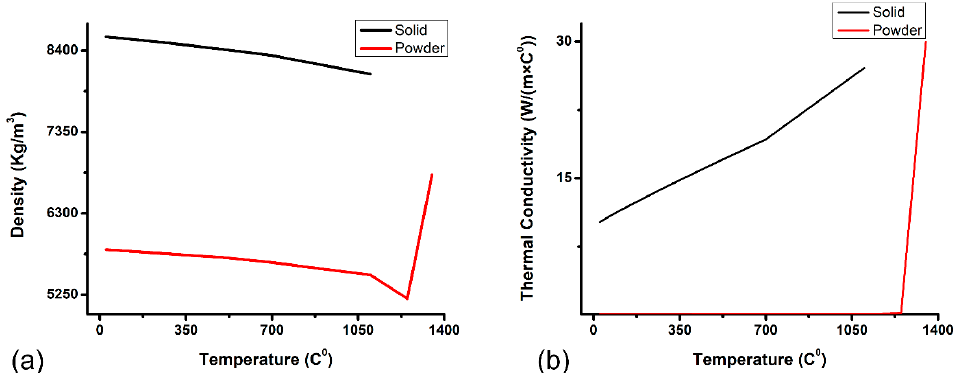
Figure 6. Temperature-dependent material modeling for powder Inconel ® 718. ( a ) Density. ( b ) Ther- mal